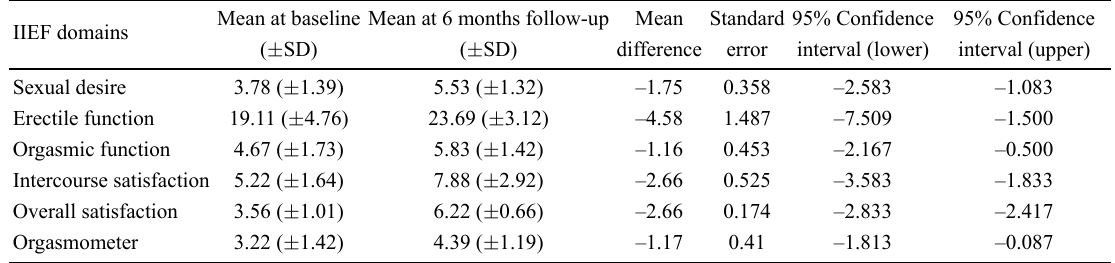
Table 4. Bootstrap* for Paired Samples t -test. IIEF-domains and Orgasmometer score at baseline and after 6 months